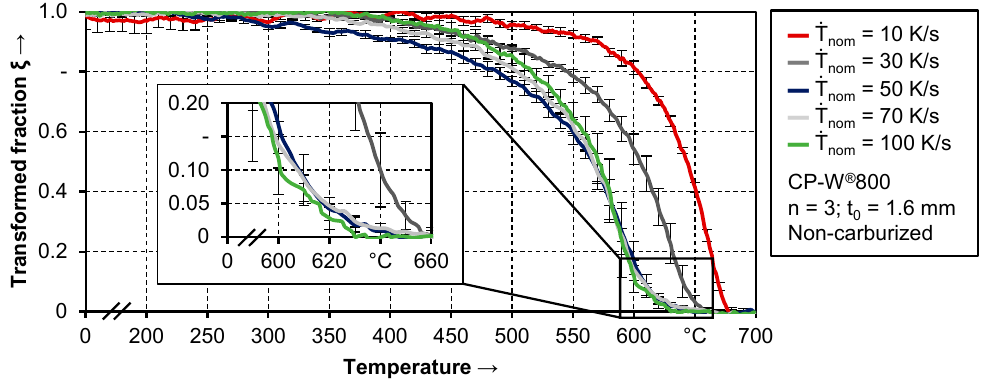
Figure 5. Decomposition of the austenitic phase during quenching of non-carburized samples.